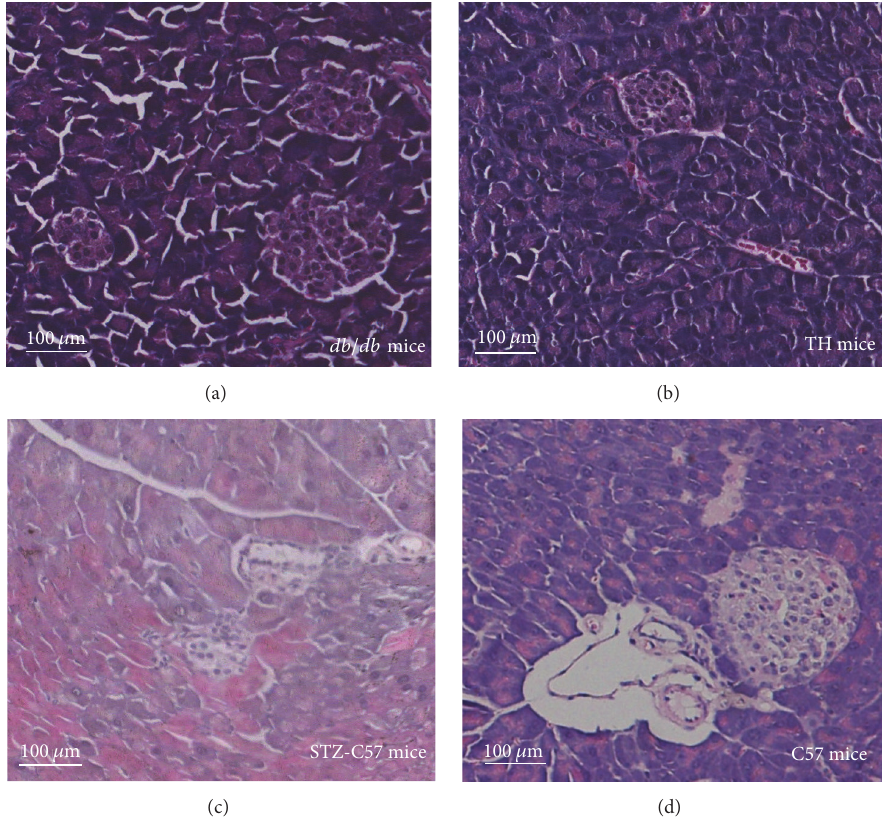
Figure 6: Pancreas morphology featured T1D and T2D in the four types of mice were observed in HE staining images.